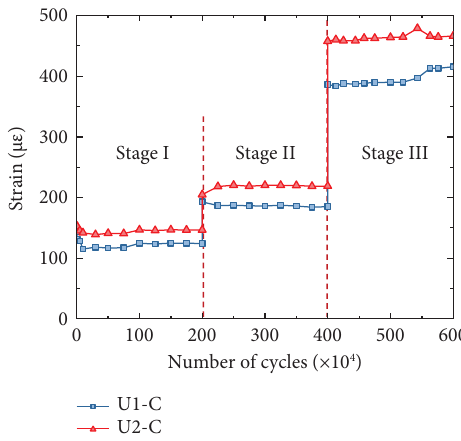
Figure 19: Load-strain curves of rib-to-diaphragm